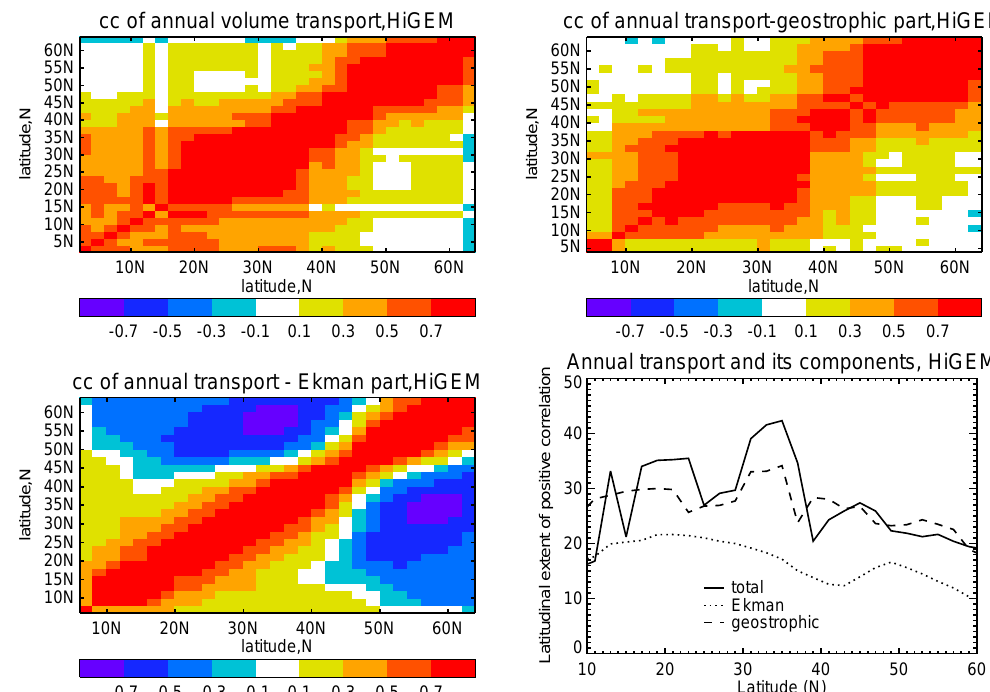
Fig. 9. Cross-correlation of ocean meridional overturning transport, T over and its physical components, between latitudes in the North Atlantic in HiGEM: annual T over (top left), geostrophic, T geo (top right), Ekman, T ek (bottom left) and their meridional correlation length (bottom right). Correlation length ( ◦ lat) as a function of latitude y is defined as the width of the range of latitudes whose timeseries which have a temporal correlation exceeding 0.5 with the timeseries at latitude y .